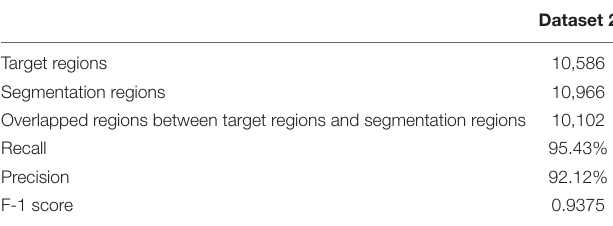
TABLE 4 | Object detection results of the DeFrame system.